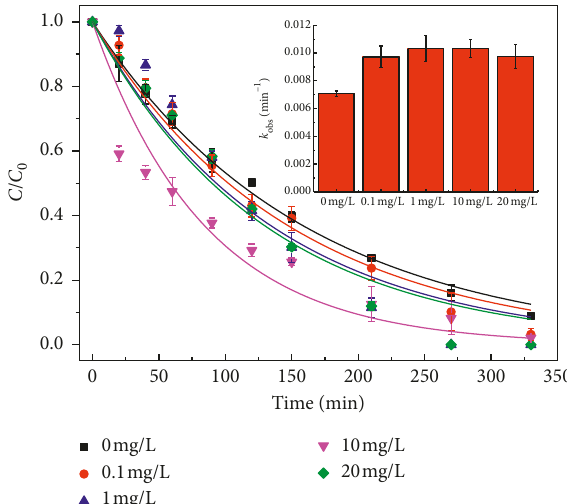
Figure 8: Effects of HA concentration on AMO degradation by TAP. Solid lines represent the pseudo-first-order kinetic model fits. Insert: changes of k obs at different HA concentrations. Experi- mental conditions: [AMO] 0 � 0.1 mM; [PS] 0 � 10 mM; T � 50 ° C; reaction time � 330min.